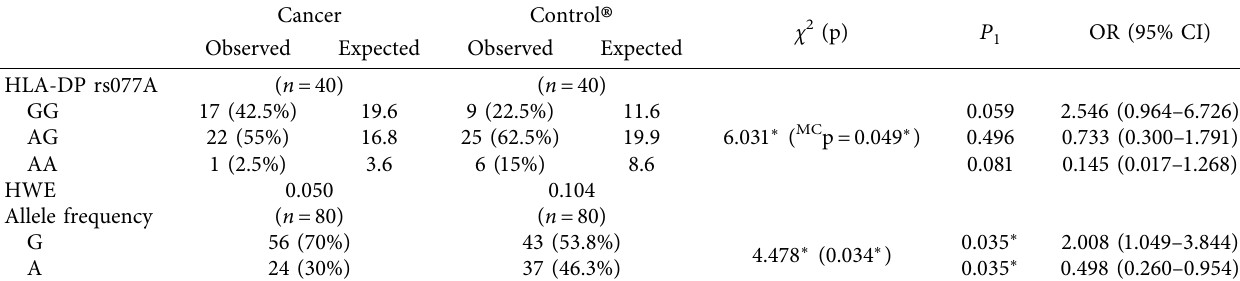
Table 2: Comparison between the two studied groups according to different genotypes.